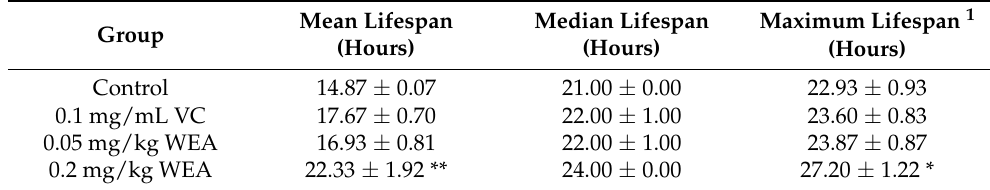
Table 1. Effects of WEA on the lifespan of Drosophila . Group